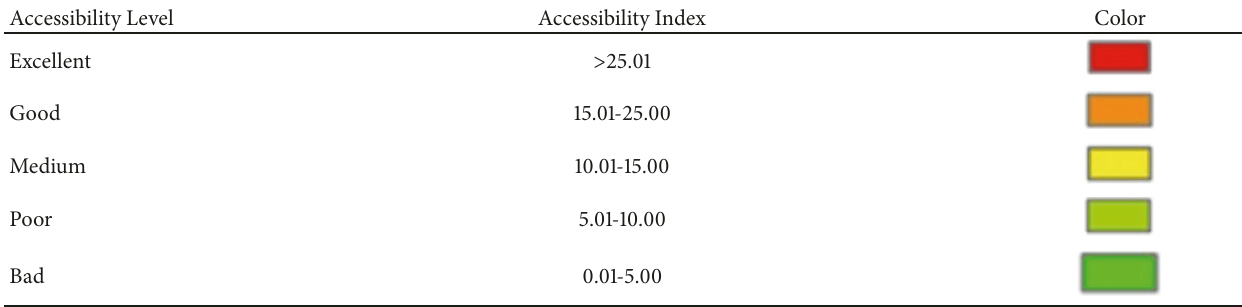
Figure 6: Shenzhen public transport accessibility evaluation. Table 1: The correspondence between accessibility index and accessibility